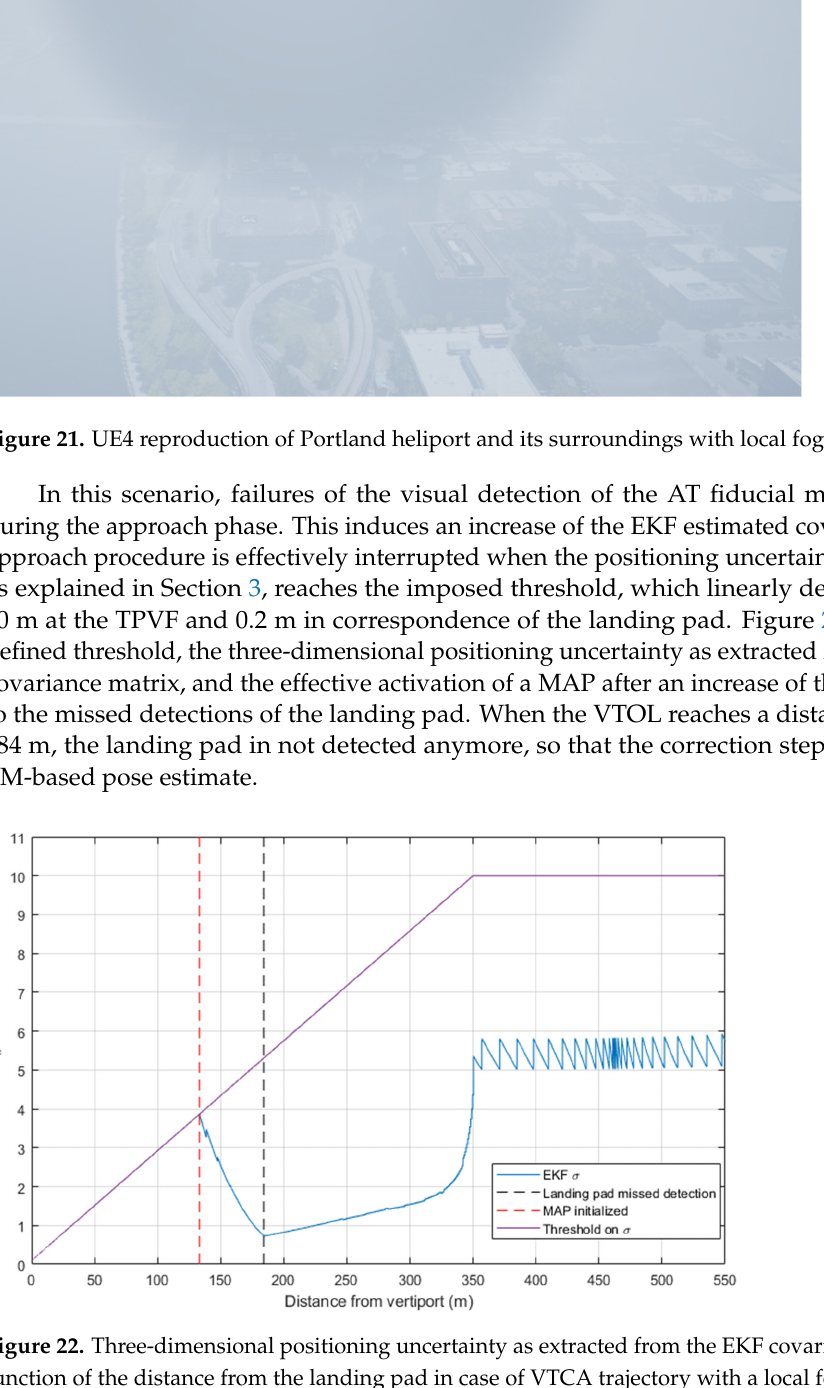
Figure 20. Difference in pixel coordinates of the 4 detected AT corners between image frames col- lected in the perturbed and in the low − visibility test cases along a VTCA approach trajectory. Cor- ners’ legend is referred to the biggest marker of Figure 6a.